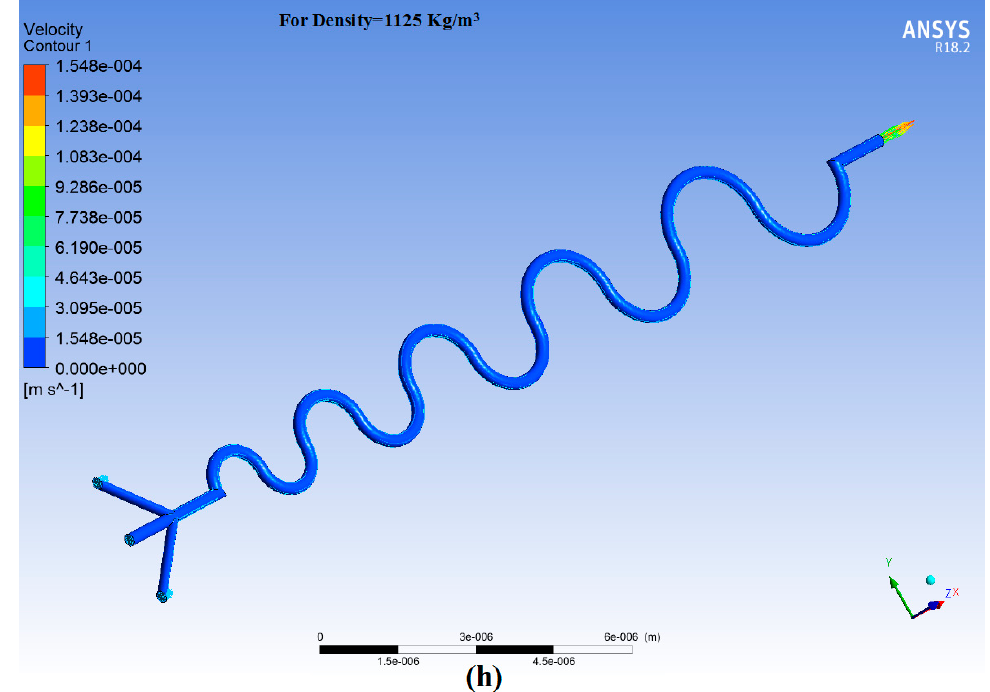
Figure 10. ( a – h ) Contours of Pressure and Velocity at different densities in the case of 5CACMC. The simulation results for 5CDCMC are shown below in Figure 11.